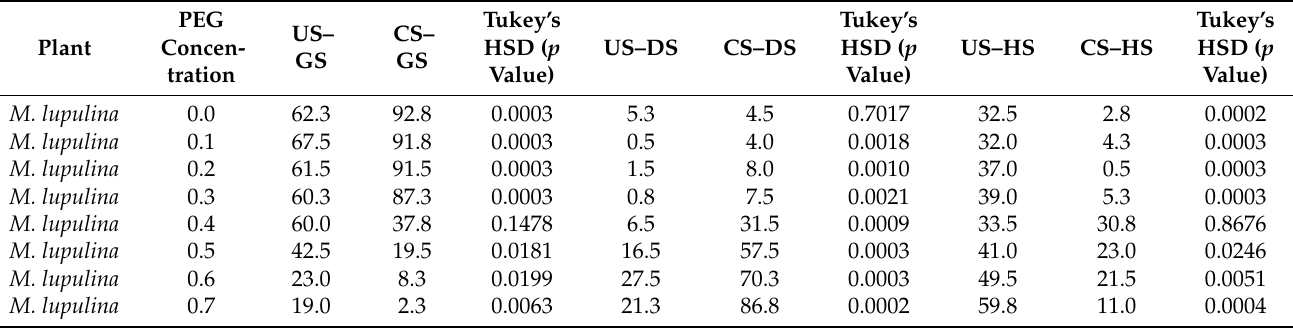
Table A6. Results of Tukey’s HSD test— M. lupulina .